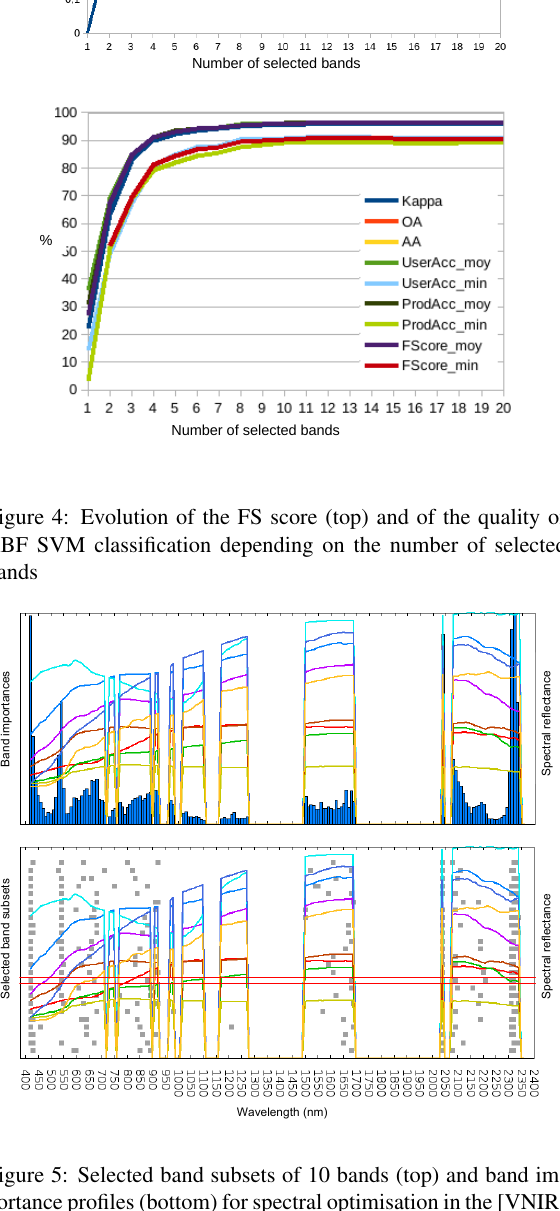
Figure 5: Selected band subsets of 10 bands (top) and band im- portance profiles (bottom) for spectral optimisation in the [VNIR- SWIR] (420-2400 nm) spectral domain. (red frame = final solu- tion)